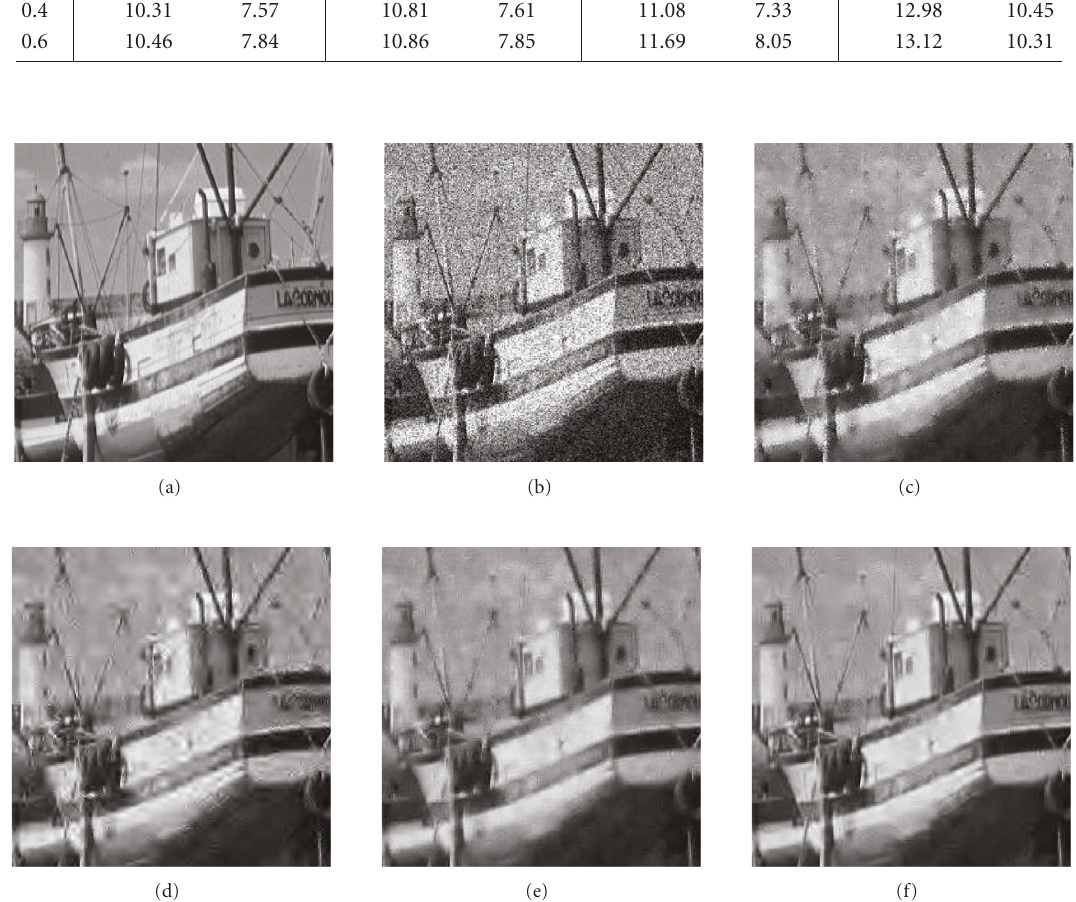
Figure 4: Portion of the Boat image: (a) original, (b) film-grain noised at 2.9dB ( γ = 0 . 4), (c) LLMMSE filtered, (d) adaptive wavelet denoised, (e) LADCT-8, (f) LADCT-1 filtered.